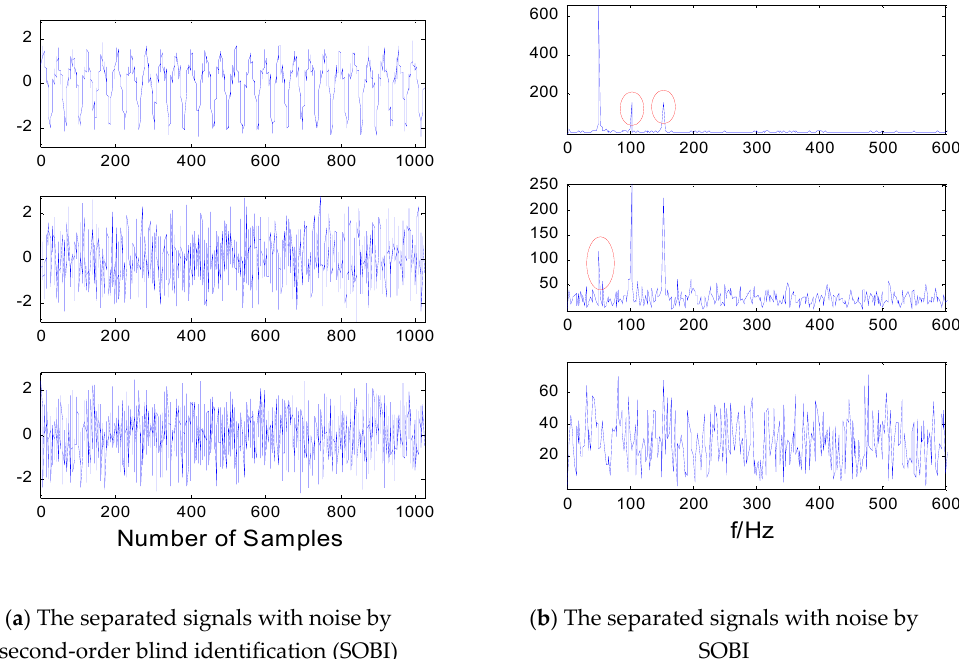
Figure 5. The frequency domain signals of the SOBI algorithm.